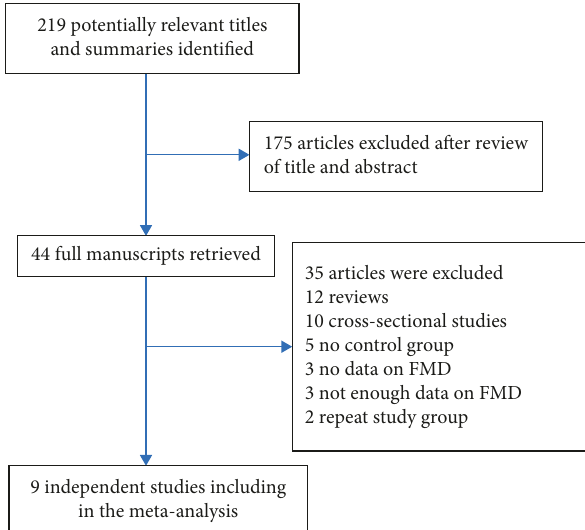
Figure 1: Flowchart of the selection of studies included in meta-